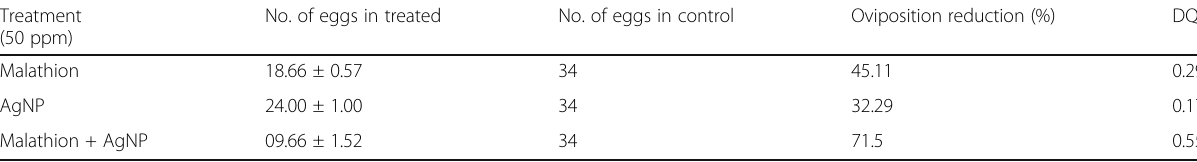
Table 4 Ovipositional deterrent assay of Tribolium castaneum treated with silver nanoparticles, malathion, and its combination Treatment No. of eggs in (50 ppm)